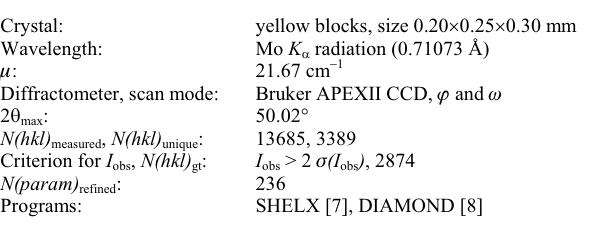
Table 1. Data collection and handling.